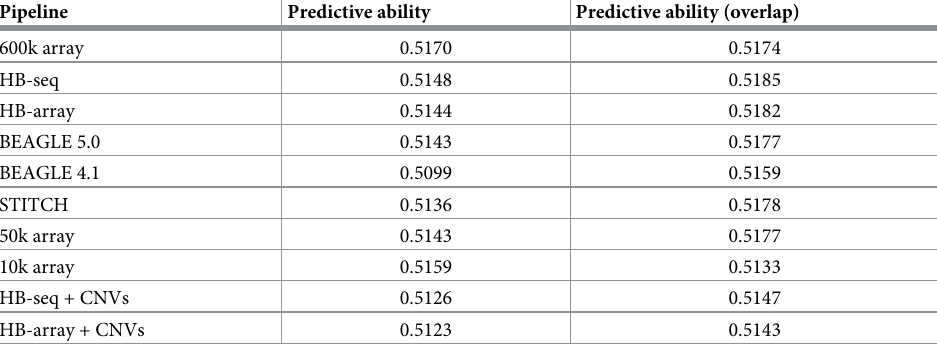
Table 3. Average predictive ability for nine maize traits [48] depending on the genotype data used for prediction. The panel of overlapping markers includes all markers included in the array and sequence data panel after quality con- trol